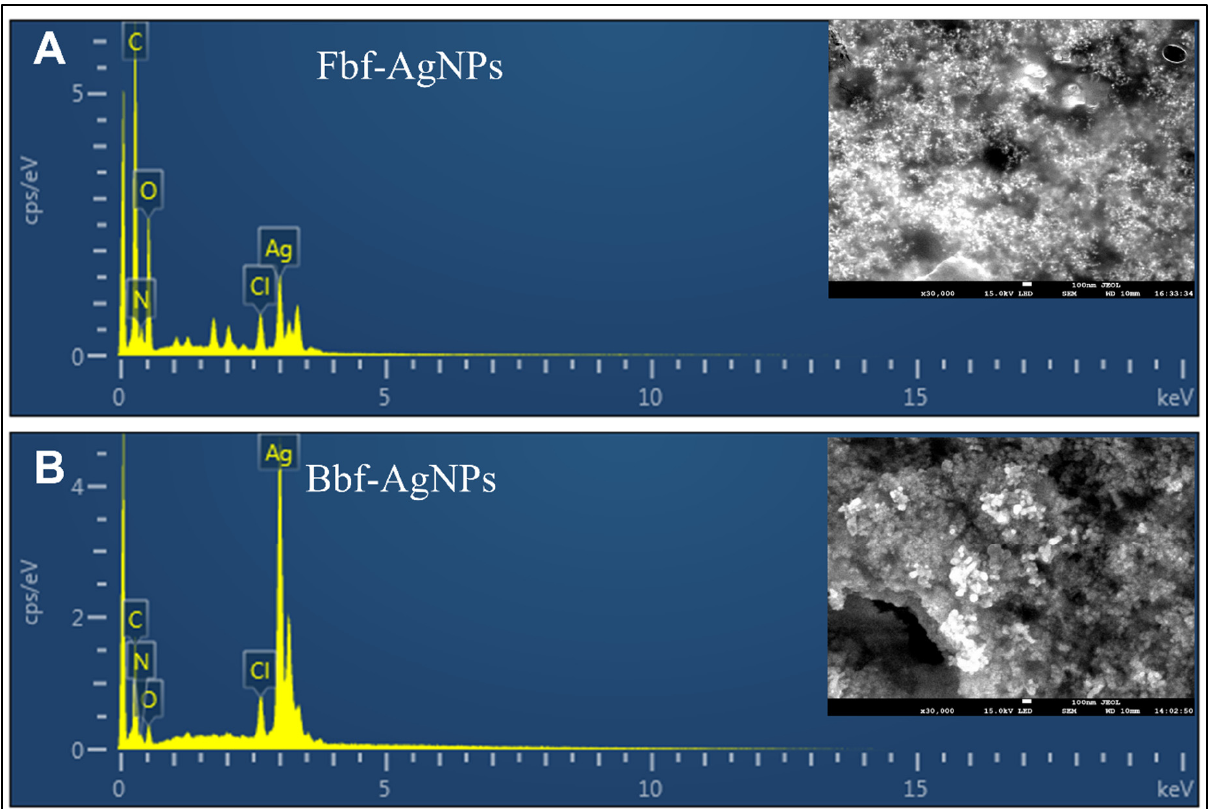
Figure 2. The SEM and EDX spectra of the biosynthesized nanoparticles showing the morphology and elemental composition. ( A ) Fbf-AgNPs and ( B ) Bbf-AgNPs .